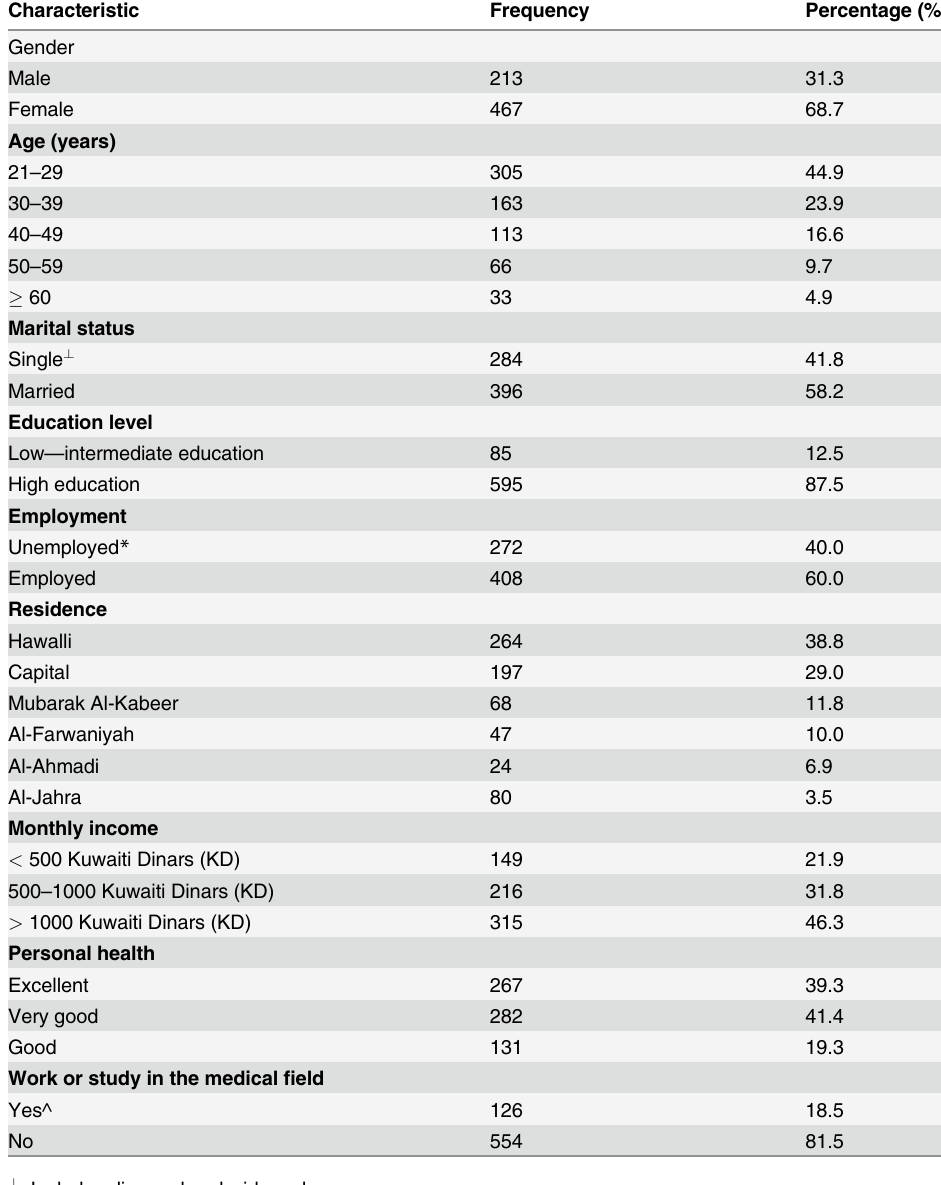
Table 1. General Characteristics of Respondents (n =